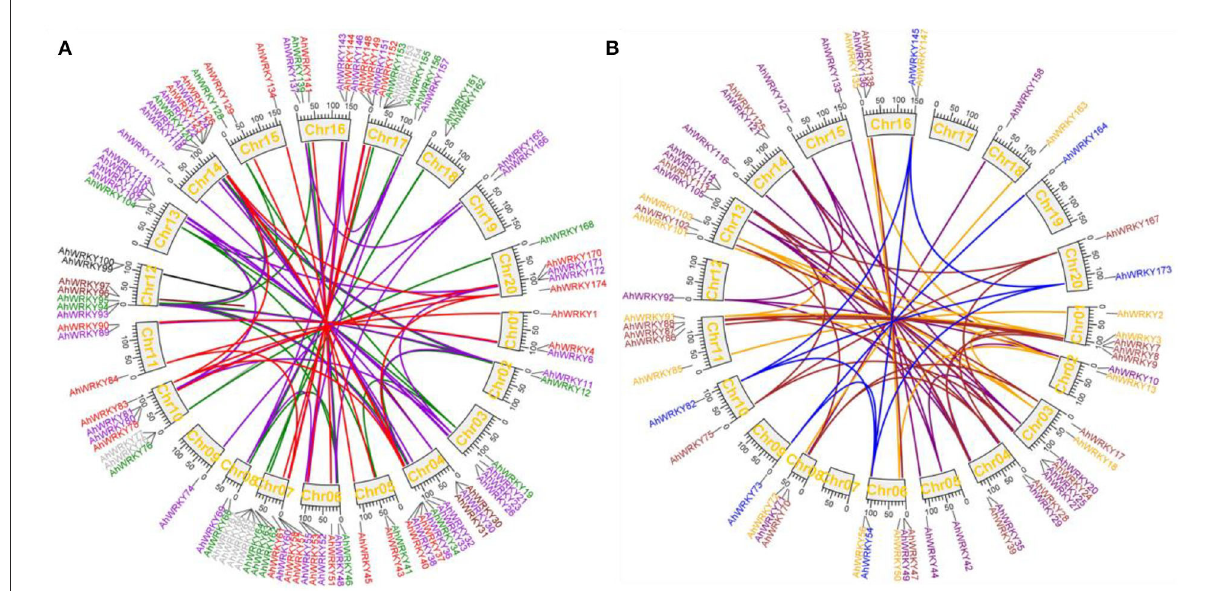
FIGURE3 Circos figures for chromosome locations with AhWRKY duplication links. (A) Groups I, II-c, and III subfamily duplication links. Red, dark violet, and green lines indicated groups I, II-c, and III subfamily segmented, and black, maroon, and dark gray lines indicated groups I, II-c, and III subfamily tandem duplicated gene pairs, respectively. (B) Groups II-a, II-b, II-d, and II-e subfamily duplication links. Blue, brown, orange, and purple lines indicated group II-a, II-b, II-d, and II-e subfamily segmented duplicated gene pairs,